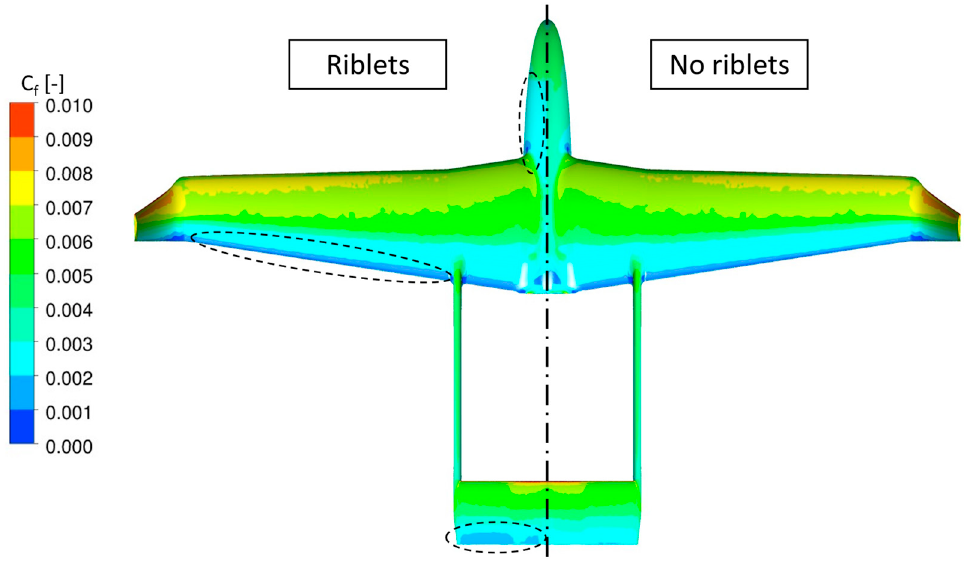
Figure 13. Skin friction coefficient distribution on the surface of the RX-1 HCUAV with riblets ( left ) and without ( right ).